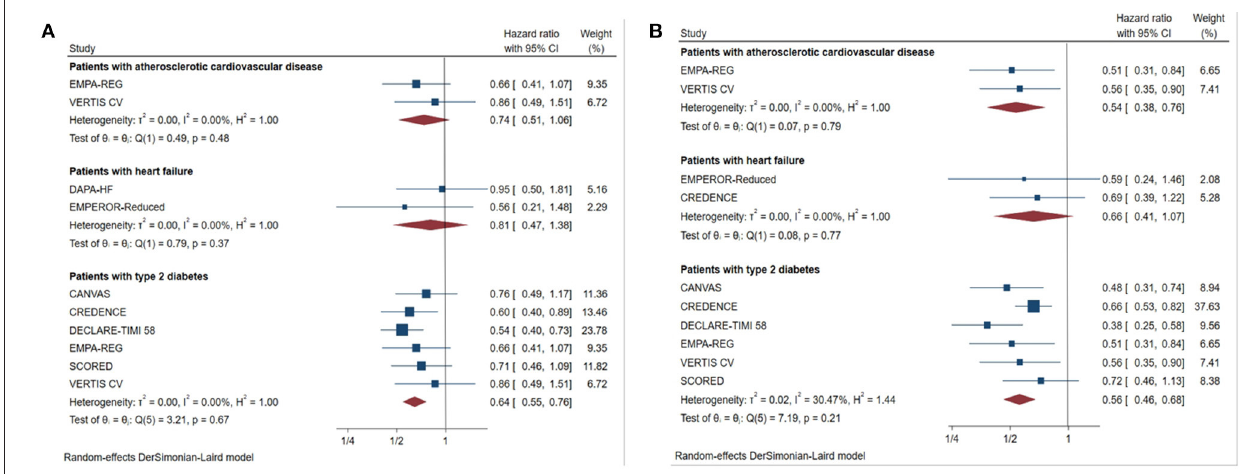
FIGURE 4 | Effect of SGLT2 inhibitors on ESKD, worsening kidney function, or death because of kidney disease in patients with different complications. (A) eGFR < 60mL/min/1.73m ² ; (B) UACR > 300 mg/g; CI, confidence interval; worsening kidney function: defined as doubling of serum creatinine or sustained 40% decline in eGFR; ESKD, defined as requirement for chronic dialysis or kidney transplantation, or sustained eGFR < 15 mL/min/1.73 m ² .